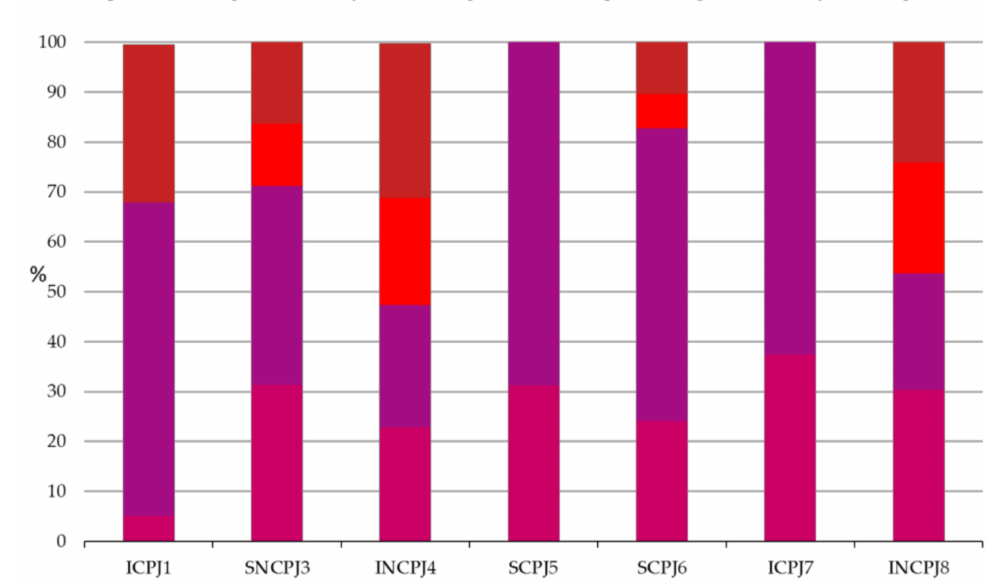
Figure 1. Distribution (%) of the anthocyanins of PJs